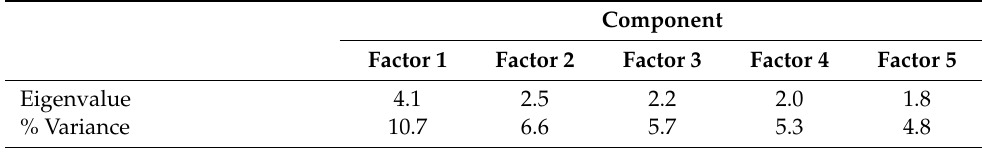
Table 3. Factor Loadings on FNASS and NNNS